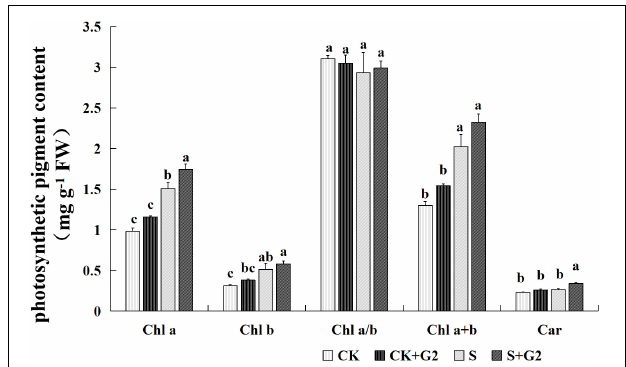
FIGURE 3 | Effects of B. cereus G2 inoculation on photosynthetic pigment contents in G. uralensis seedlings under control and salt stress conditions. CK, control group; S, salt stress group; CK + G2, control combined with the G2 group; S + G2, salt stress combined with the G2 group. The different letters within the different treatments in the same parameter indicate the significant difference at the 0.05 level. Values are means ± SE ( n = 3). Chl a , chlorophyll a ; Chl b , chlorophyll b ; Car,